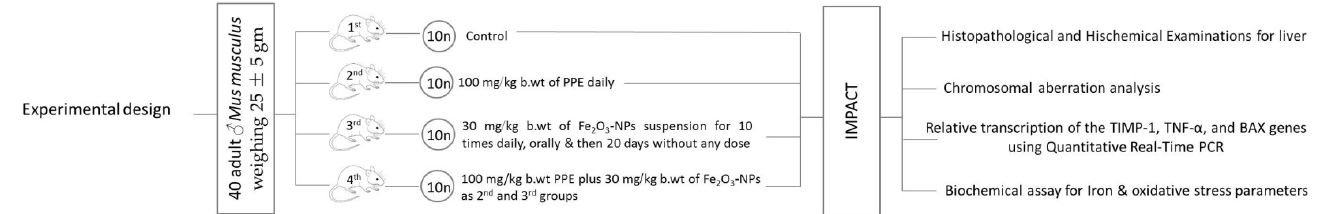
Table 1. Experimental design for different groups.